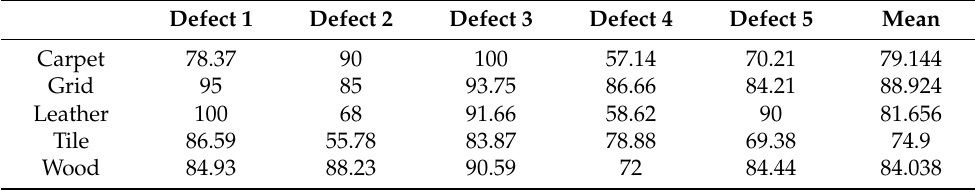
Table 9. CCP obtained with the convolutional autoencoder for all textures and errors.